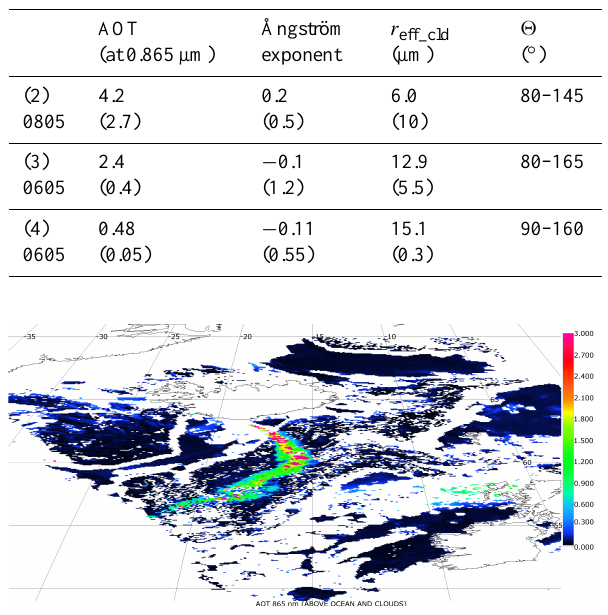
Table 2. Aerosol and cloud parameters retrieved on 8 May 2010 and 6 May 2010 for different cloudy regions covered by the ash plume and the absolute retrieval uncertainties in brackets. The region (1) on 8 May is indicated in Fig. 5a. The regions (3) and (4) on 6 May are indicated by crosses in Fig. 8.